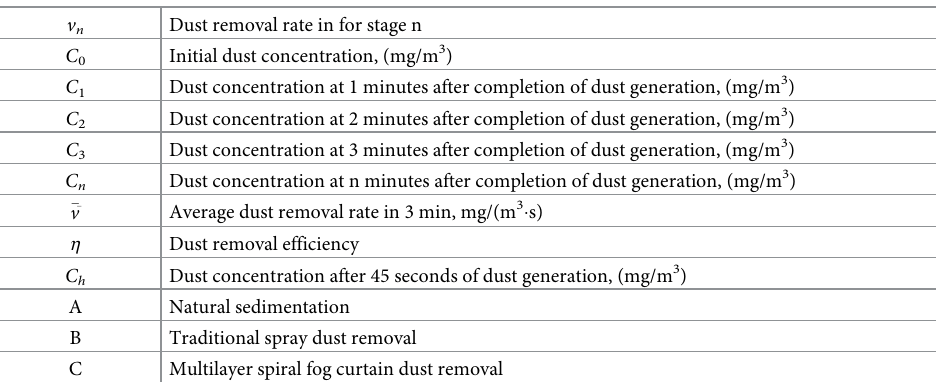
Table 3. Nomenclature